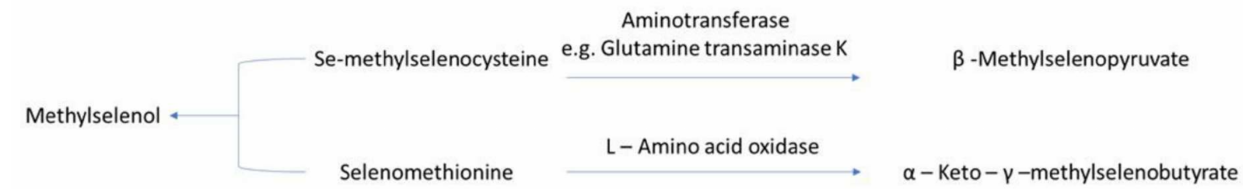
Figure 3. Summary of the formation of α -keto